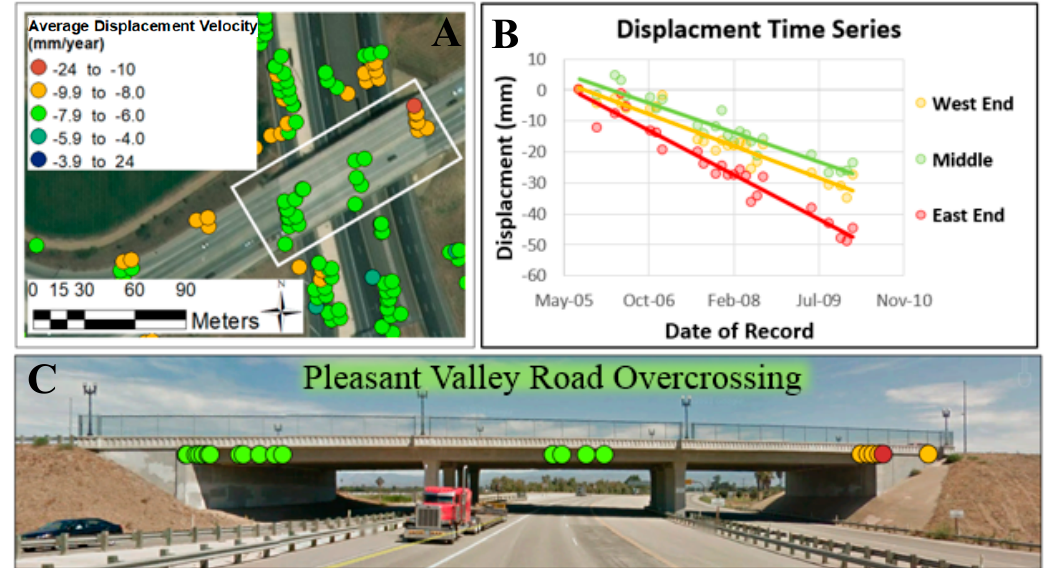
Figure 5. Pleasant Valley road overcrossing displacement model. ( A ) Aerial view of the bridge; ( B ) Displacement time series; ( C ) Elevation view of the bridge. Source: Images for Figure 5A,C were obtained from Google Earth [48].